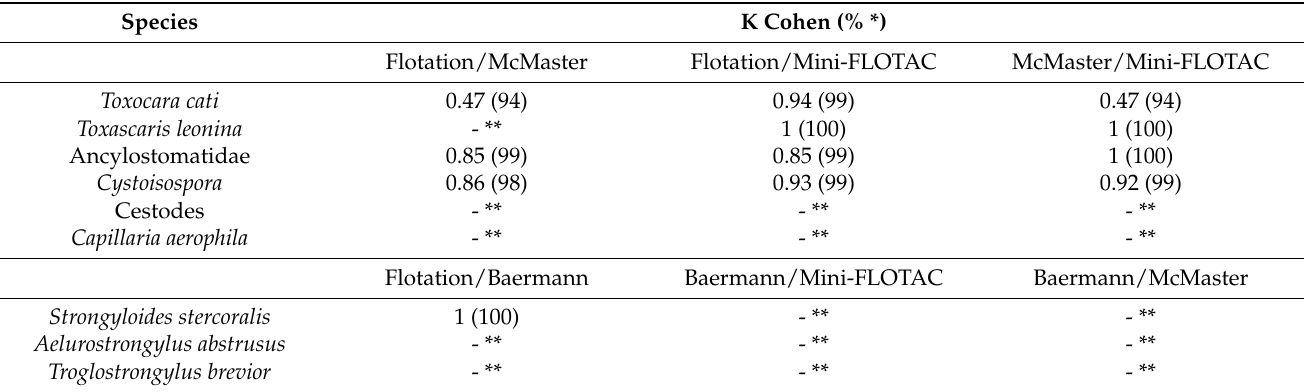
Table 12. Cohen’s kappa coefficient calculated to assess the agreement between techniques employed in the present study for feline fecal